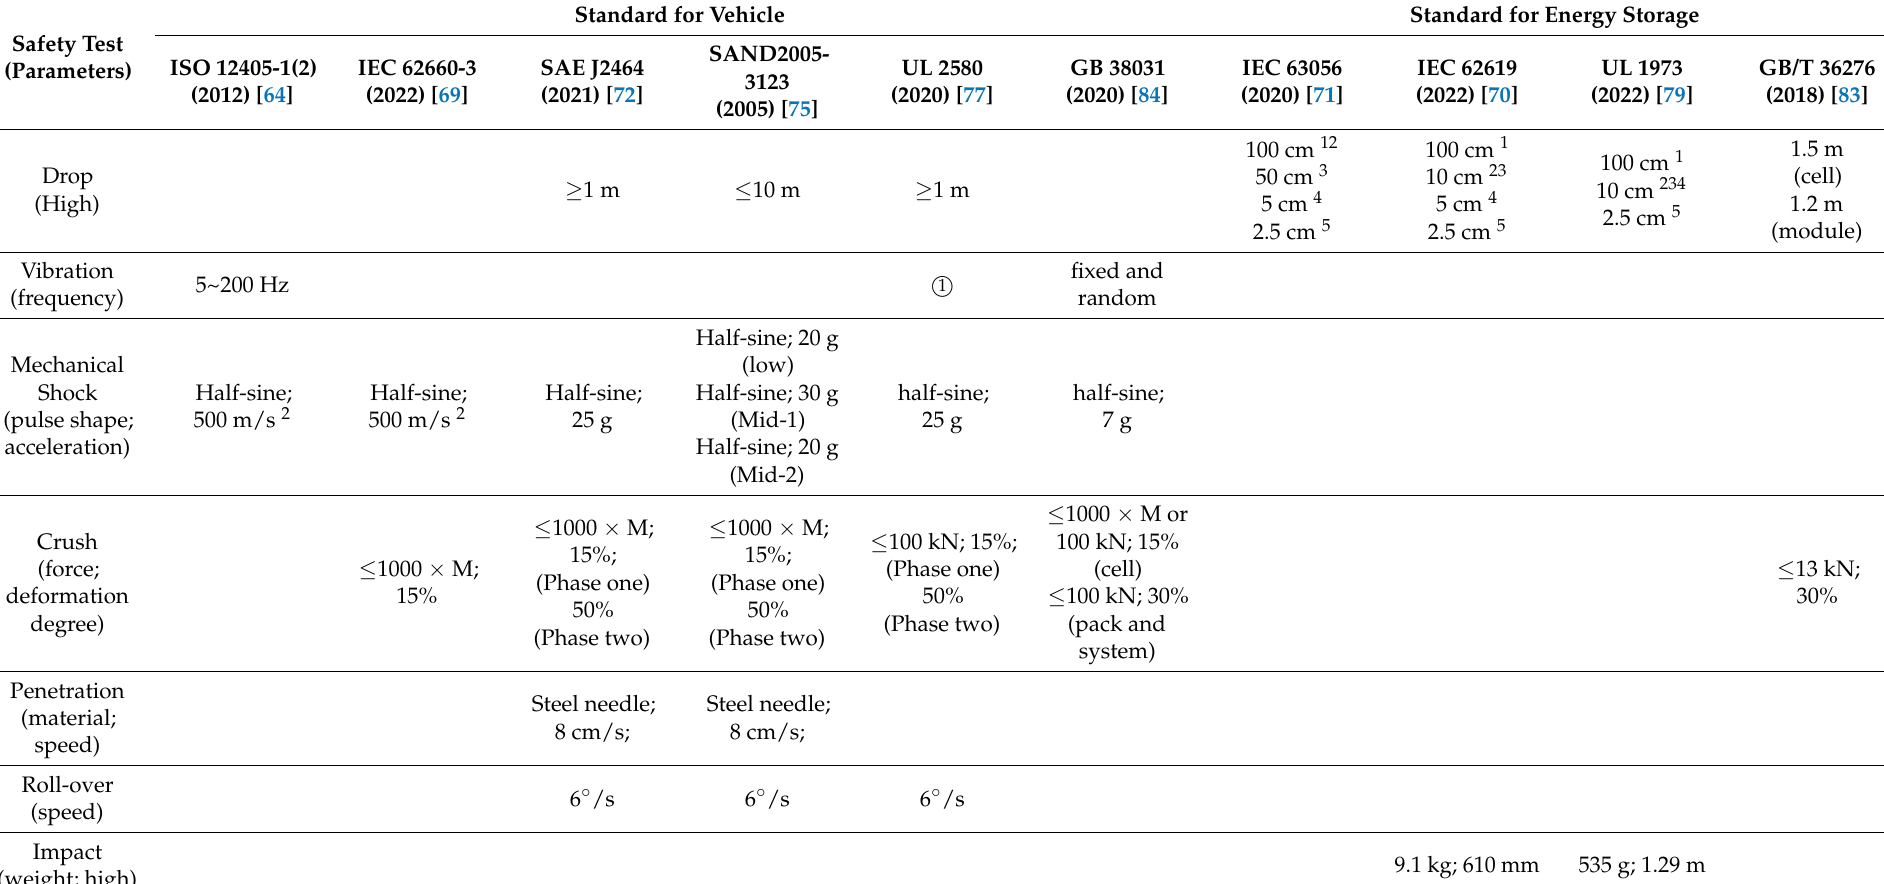
Table 2. Mechanical test standards for